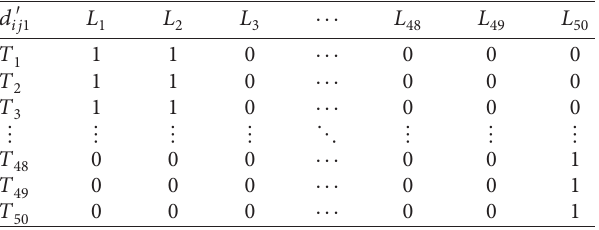
Table 12: Normative profit and loss matrix D tenants’ housing location.